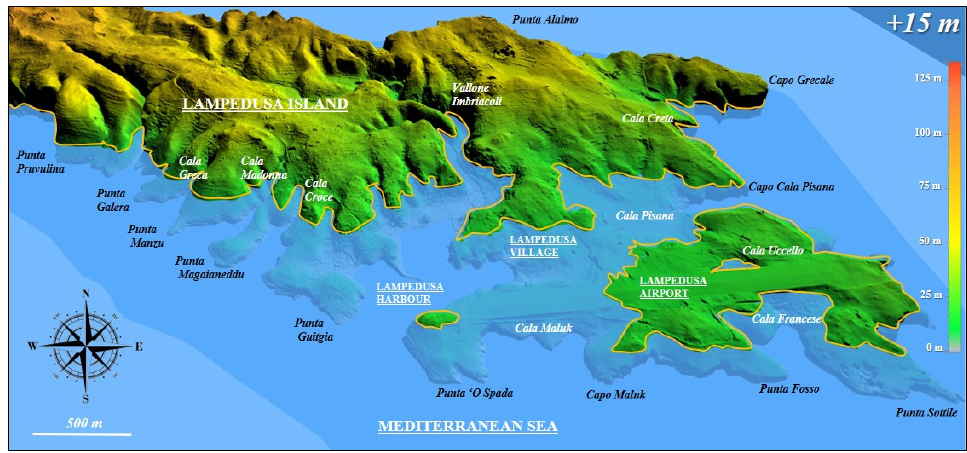
Figure 10. 3D flooding map (+15 m) along the southeastern sector of the island of Lampedusa.